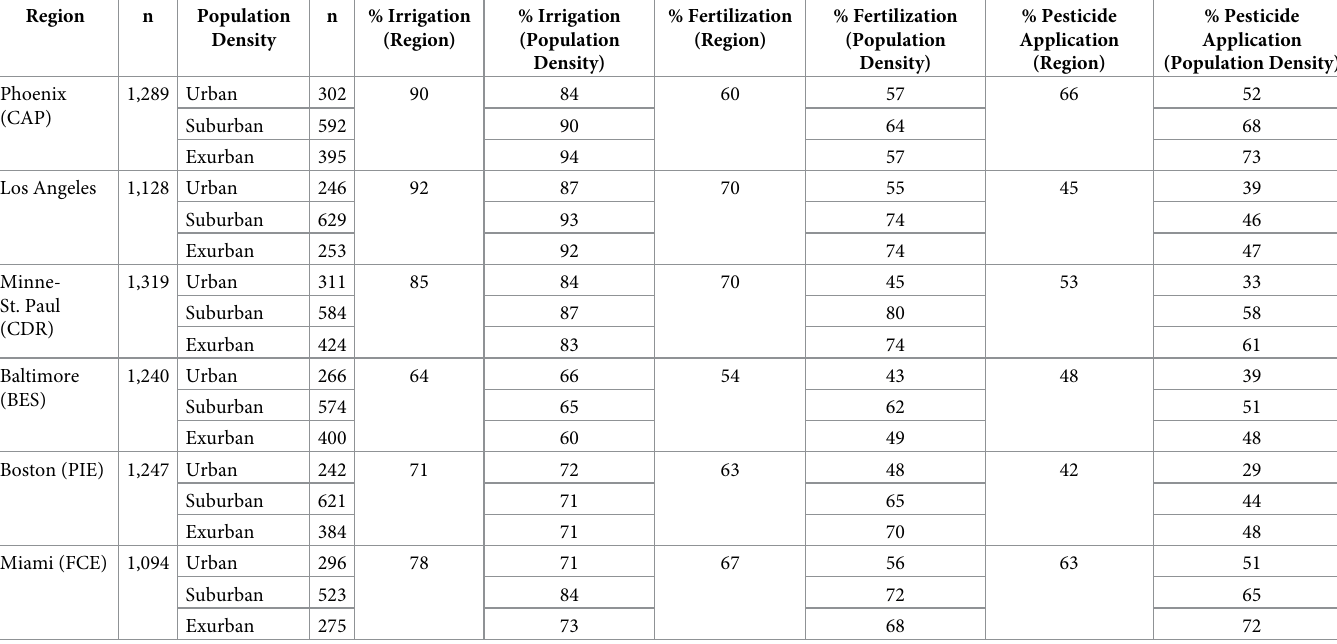
Table 2. Self-reported irrigation, fertilization, and pesticide application proportions by population density and metropolitan